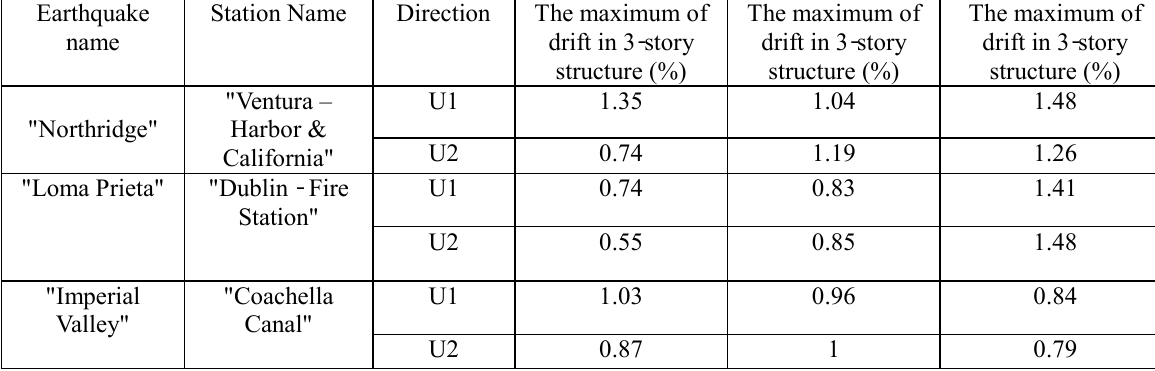
The maximum results of drift in 3, 6 and 12-story structures.